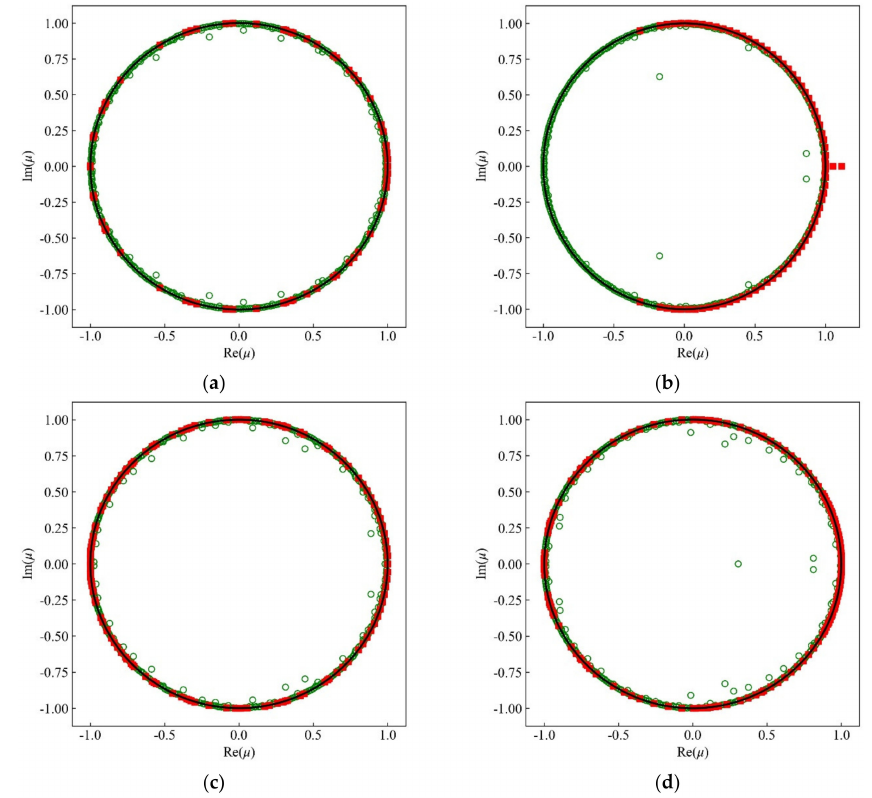
Figure 11. Ritz eigenvalue distribution of the DMD modes at di ff erent spacing ratios: ( a ) L / D = 2; ( b ) L / D = 2.5; ( c ) L / D = 3; ( d ) L / D =